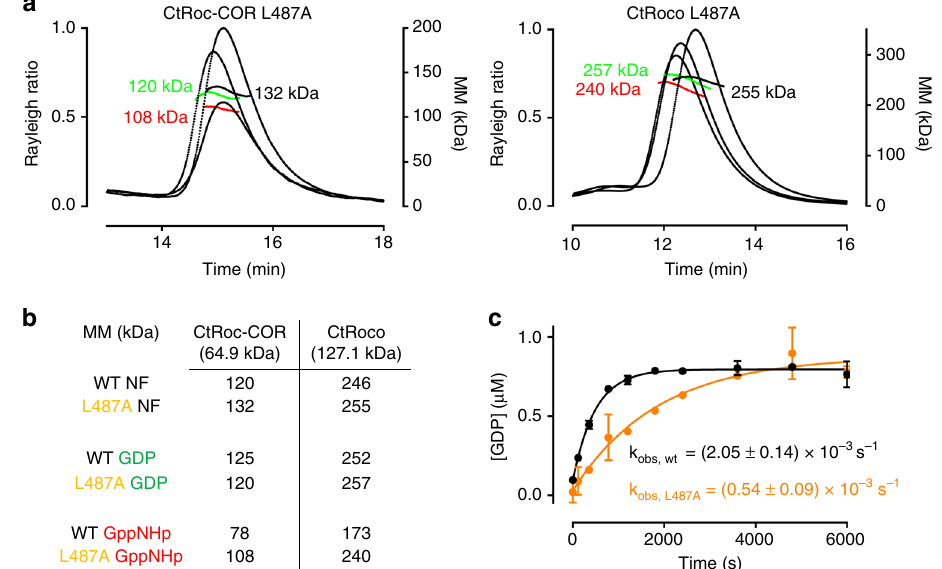
Fig. 5 Effect of a PD-analogous mutation on the CtRoco and CtRoc-COR monomer-dimer equilibrium. a SEC-MALS data for the CtRoc-COR L487A mutant ( left panel ) and the CtRoco L487A mutant ( right panel ) in the absence ( black ) or presence of nucleotides GDP ( green ) or GppNHp ( red ). b Overview of molecular masses determined by SEC-MALS for CtRoc-COR wt, CtRoc-COR L487A, CtRoco wt and CtRoco L487A in absence and presence of GDP or GppNHp. The theoretical molecular masses of the monomers are given in between brackets. (NF = nucleotide-free). c Single turnover GTP hydrolysis of CtRoc-COR wt ( black ) and CtRoc-COR L487A ( orange ) using 1 µ M protein and 1 µ M GTP. GDP formation is followed using reversed-phase HPLC. The observed rate constants (k obs ) ± s.e. for wild-type and mutant CtRoc-COR are indicated. Each data point is the average ( ± s.d.) of 3 independent